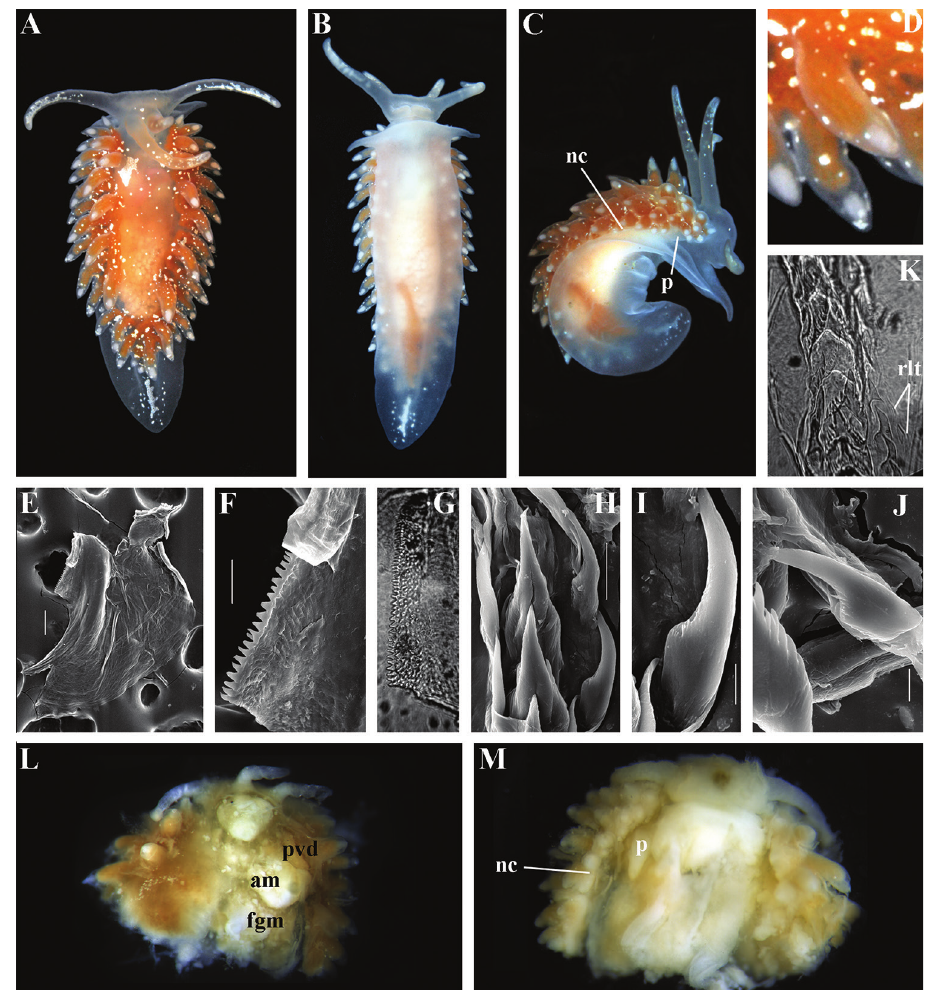
Figure 9. Paracoryphella islandica (Odhner, 1937). ZMMU Op-534. Barents Sea, Dalne-Zelentskaya Bay, living specimen 12 mm in fixed length: A dorsal view B ventral view C lateral view D same, details of cerata E jaw, SEM F details of masticatory process of jaw, SEM G details of masticatory process of jaw, light microscopy H radular teeth, posterior part, SEM I lateral tooth, close up, SEM J rachidian and lateral teeth, details, SEM K radular teeth, middle part, showing second rudimentary row of lateral teeth (rlt), light microscopy L dissected anterior part showing pharynx and reproductive system M ventral anterior part of fixed specimen showing external non-retractable penis (p). Abbreviations: am ampulla fgm female gland mass nc continuous notal edge p penis pvd prostatic bas deferens rlt rudimentary lateral teeth (second additional rudimentary row of lateral teeth) . Scale bars: E = 100 μm; F, H = 30 μm; I, J = 10 μm. Photos and SEM images by T.A. Korshunova, A.V.